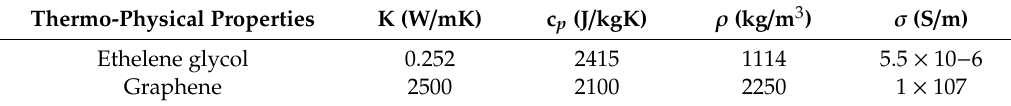
Table 1. Thermophysical properties of Ethelene glycol and graphene nanoparticles [51,52]. Thermo-Physical Properties K (W / mK) c p (J / kgK) ρ (kg / m 3 ) σ (S / m) Ethelene glycol 0.252 Graphene 2500 2100 2250 1 ×